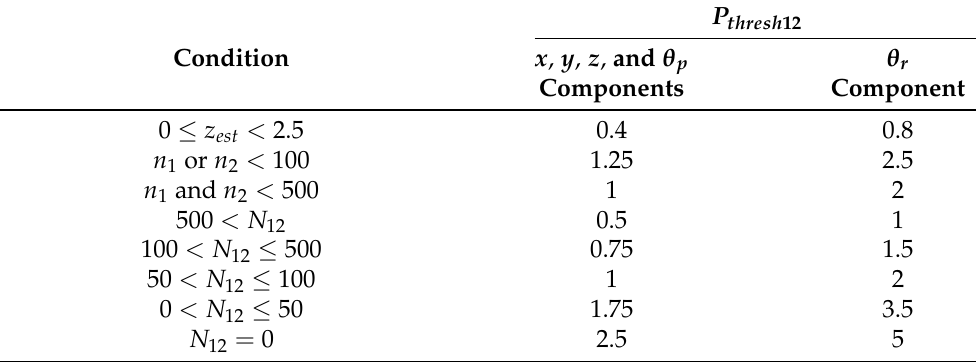
Table 3. Conditions for selecting P thresh 12 and the corresponding values for each component. The con- ditions toward the top of the list are prioritized when multiple conditions are